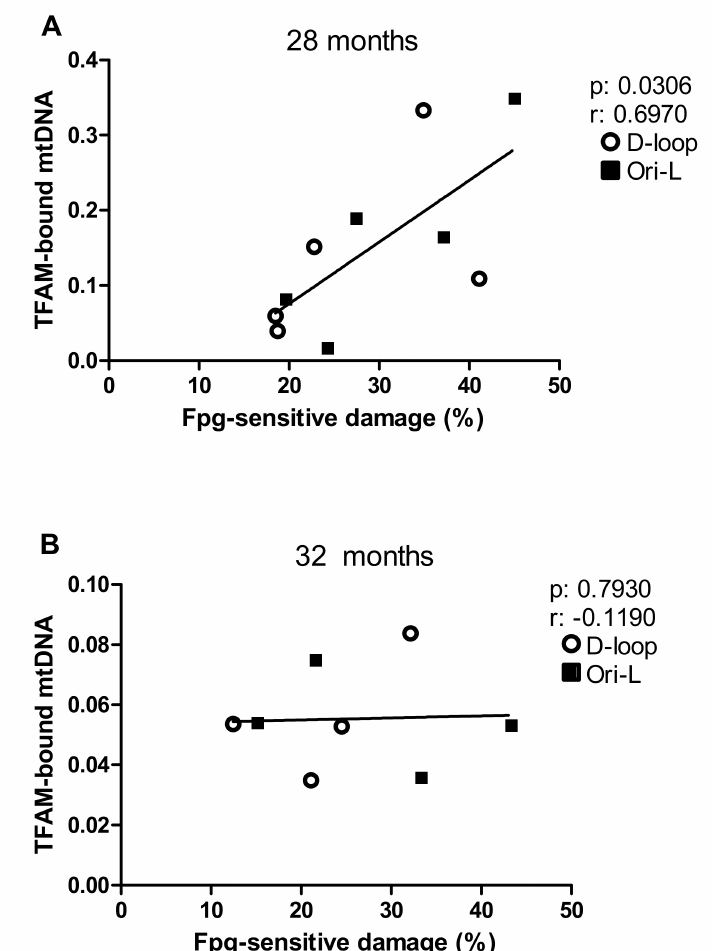
Figure 5. Correlation analysis between Fpg-sensitive damage and TFAM-bound mtDNA amounts at the D-loop and Ori-L regions by age groups. Data in the graph are mean values, obtained at the D-loop and Ori-L regions, respectively, from each analyzed rat. Number of analyzed animals: 5 in the 28-month-old group, 4 in the 32-month-old group; p, r = Spearman correlation